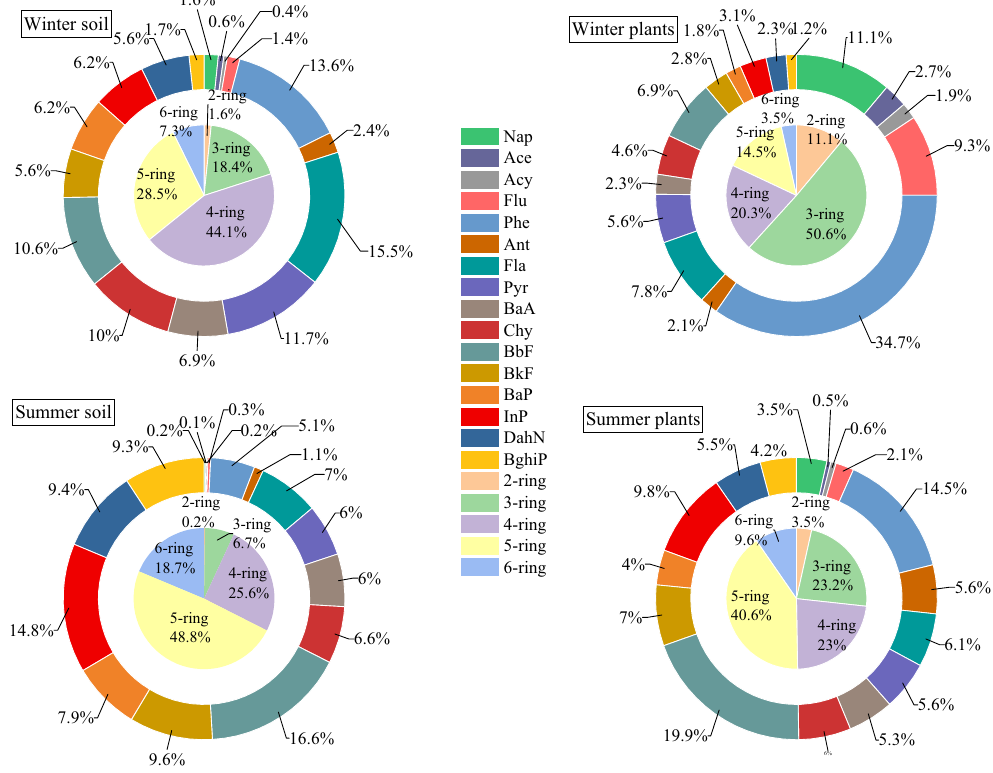
Figure 2. Single component of PAHs in soil and plants and the proportion of different ring